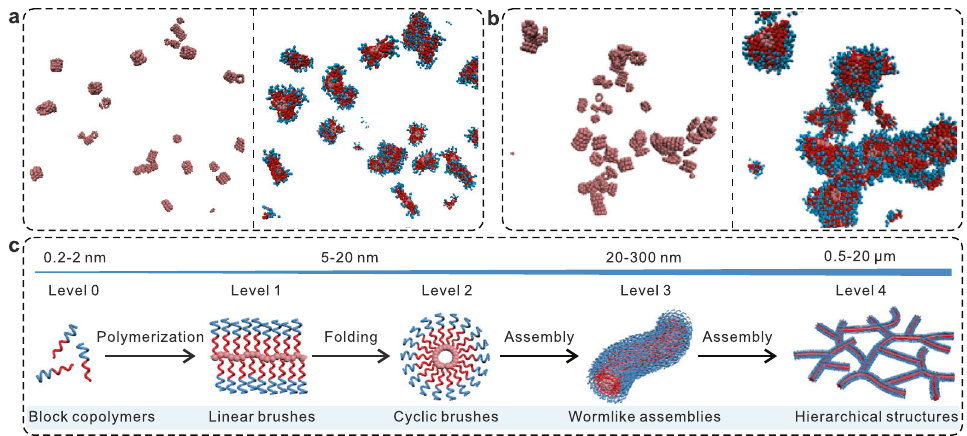
Fig. 4 Emergence of structural complexity by self-assembly of cyclic brush polymers. a , b Molecular simulation results showing the self-assembly of cyclic brush polymers for the two different concentrations, ρ = 0.0002 σ ‒ 3 ( a ) and 0.0009 σ ‒ 3 ( b ). The left panels show only the hydrophobic backbones and the right panels illustrate the full molecules. c Formation of hierarchical structures by synthetic polymers via biomimetic folding and